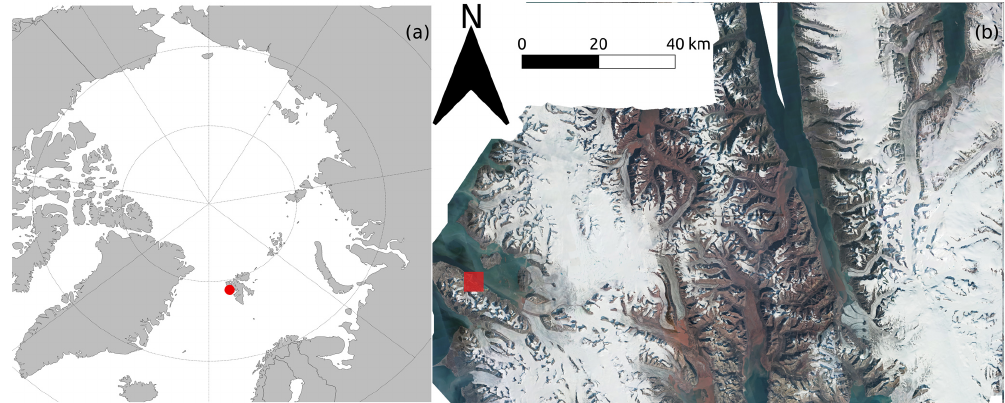
Figure 1. Location map (a) of Ny Ålesund (Svalbard islands, Norway) (red circle) and zoom (b) on the Gruvebadet observatory (red square) (courtesy of Norwegian Polar